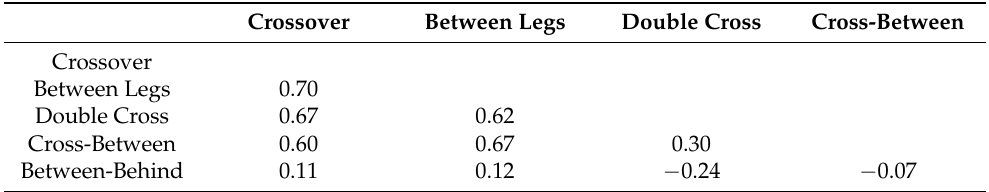
Table A1. Correlations between basketball tests results in both groups and sessions ( n = 48). Values in red denote significant correlations at p < 0.05.